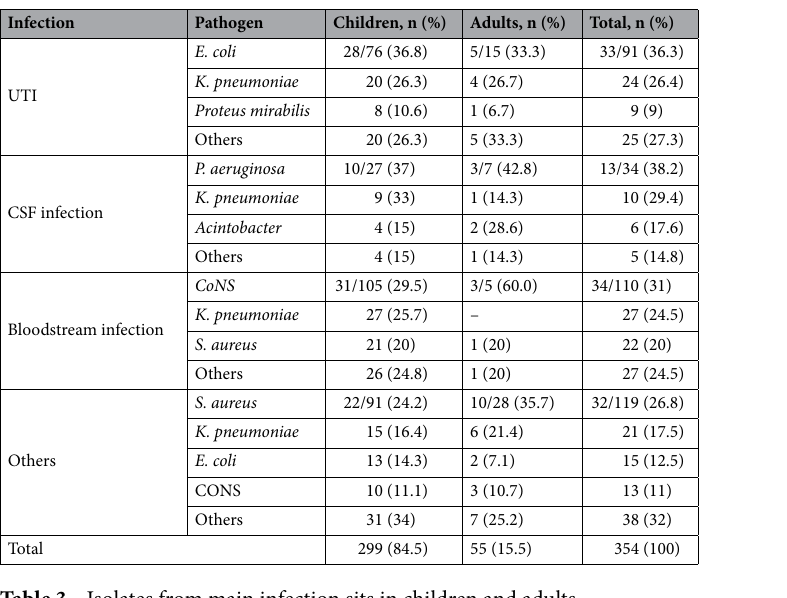
Table 3. Isolates from main infection sits in children and